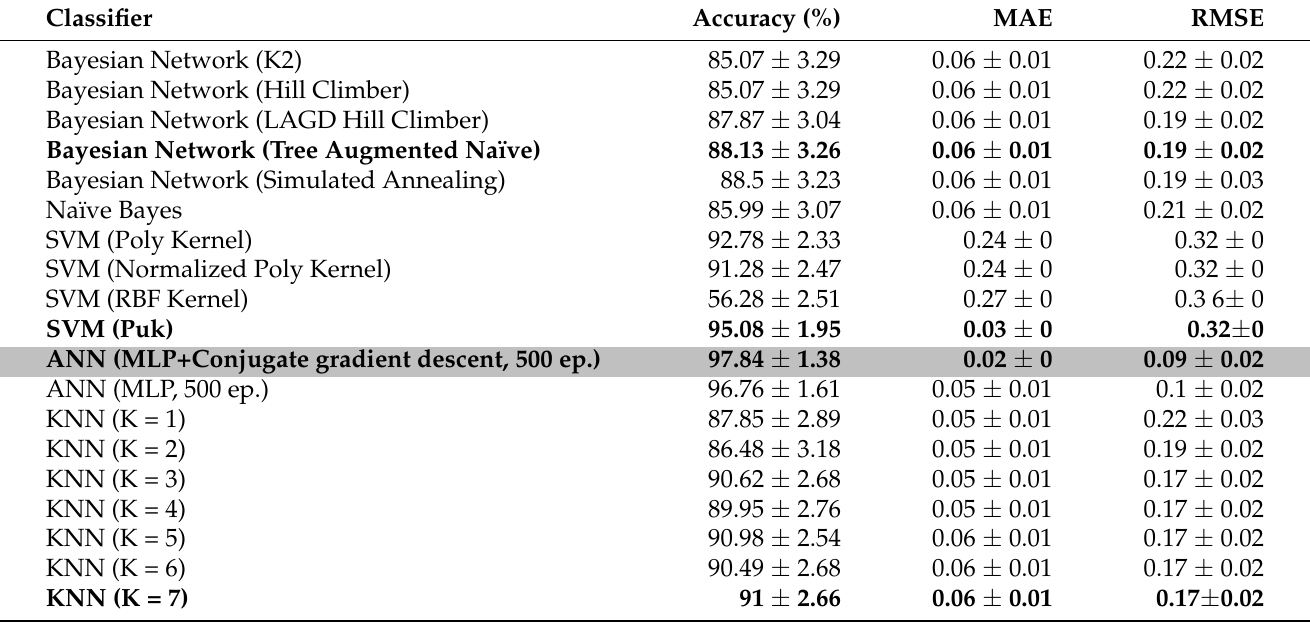
Table 5. Results and characteristics of the nodule size classification. Results in bold are the best from each algorithm type, and the one colored in gray has the highest accuracy (%) and lowest error overall. All results (i.e., accuracy, MAE, and RMSE) include the standard deviation for each fold in the k-fold cross